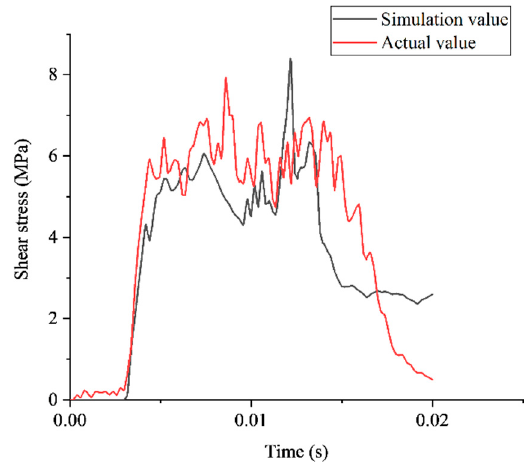
Figure 14. Trend of shear stress.